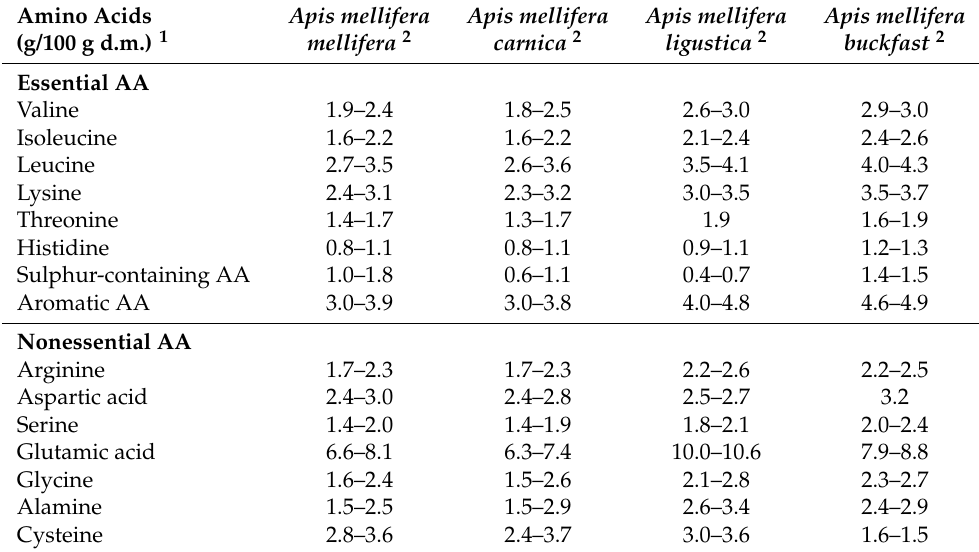
Table 4. Amino acid profile of drone pupae of Apis mellifera subspecies [38].